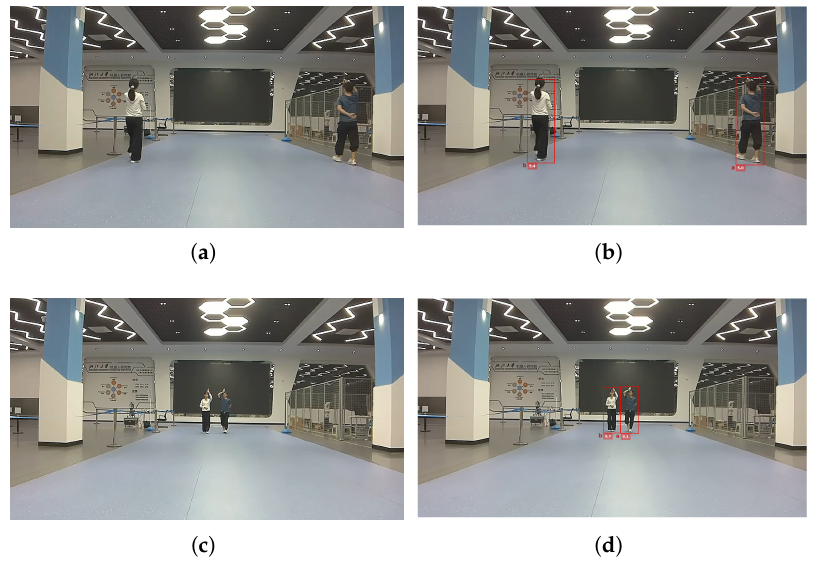
Figure 5. Monocular 3D pedestrian detection results. ( a ) Raw RGB capture example 1. ( b ) 3D detection example 1. ( c ) Raw RGB capture example 2. ( d ) 3D detection example 2.